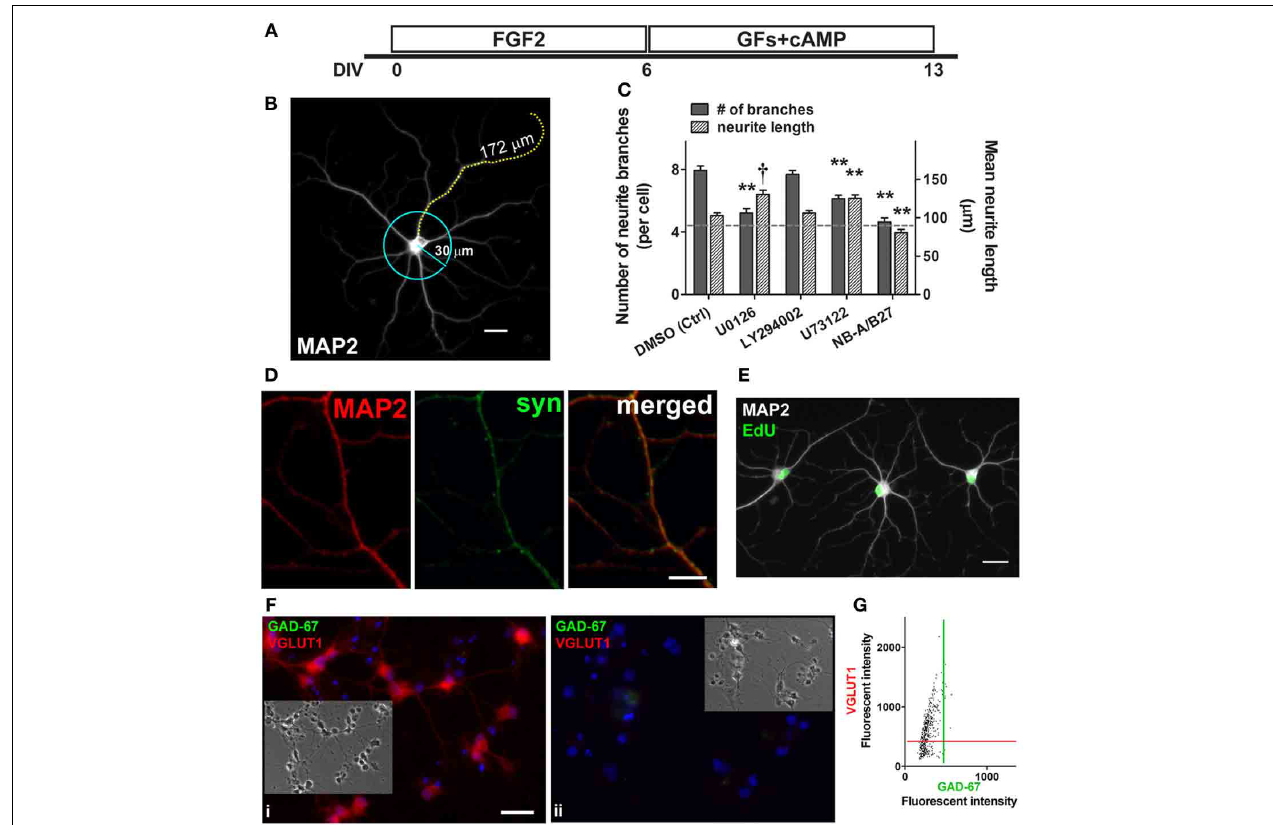
FIGURE 5 | Neurites branching requires ERK1/2 and PLC γ activation; some neurons form synapses and are glutamatergic. (A) Schematic of experimental protocol used in the neurite studies. FGF2 was present in culture to expand nestin + NSPCs (0–6DIV). Culture medium containing FGF2 was then replaced with BDNF, GDNF (GFs), and cAMP to promote further differentiation of MAP2 + neurons (6–13DIV). (B) A typical MAP2 + neuron derived from an adult spinal cord NSPC culture (13DIV). The number of neurite branches of each MAP2 + neuron in each treatment was analyzed by scoring those branches that intersected the perimeter of a 30 μ m-circle. The mean neurite length was quantified by measuring the length of the longest neurite of each MAP2 + neuron in each treatment. Scale bar: 20 μ m. (C) Quantification of neurite branching (solid bars) and neurite length (patterned bars) of MAP2 + cells (13DIV). Dotted gray line represents average measurements (left Y-axis: number of neurite branches; right Y-axis: mean neurite length) at 6DIV before growth factor treatment. By 13DIV, added growth factors increased neurite branches in DMSO control from 4.0 ± 0.4 (at 6DIV) to 7.9 ± 0.3 (at 13DIV) ( n = 25 and 87 cells, respectively). The number of branches in NB-A/B27 control with no added growth factor (4.6 ± 0.3 at 13DIV; n = 94 cells) remained similar to that at 6DIV (4.0 ± 0.4; n = 25 cells). Neurite branching of MAP2 + neurons was significantly suppressed when the activation of ERK1/2 and PLC γ was respectively blocked by 10 μ M U0126 (5.2 ± 0.3 at 13DIV; n = 83 cells) and 2.5 μ M U73122 (6.1 ± 0.2 at 13DIV; n = 96 cells). The blockage of the activation of ERK1/2 and PLC γ resulted in an increase in